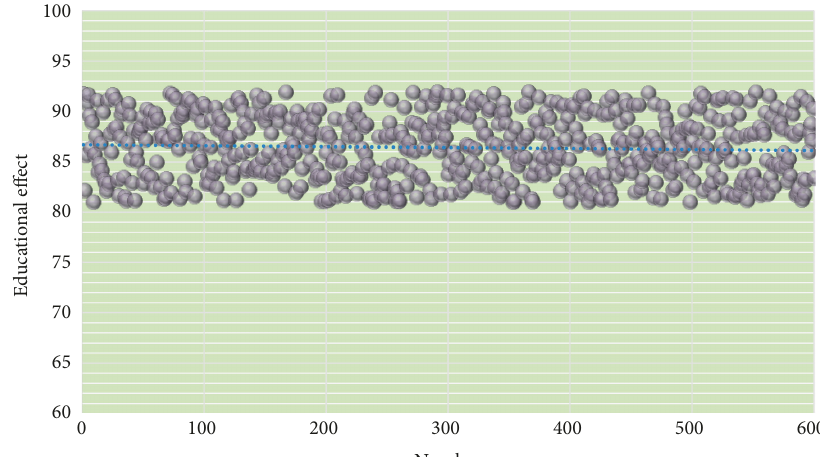
Figure 8: Cluster analysis of the ECQE model for college students under the background of “Internet